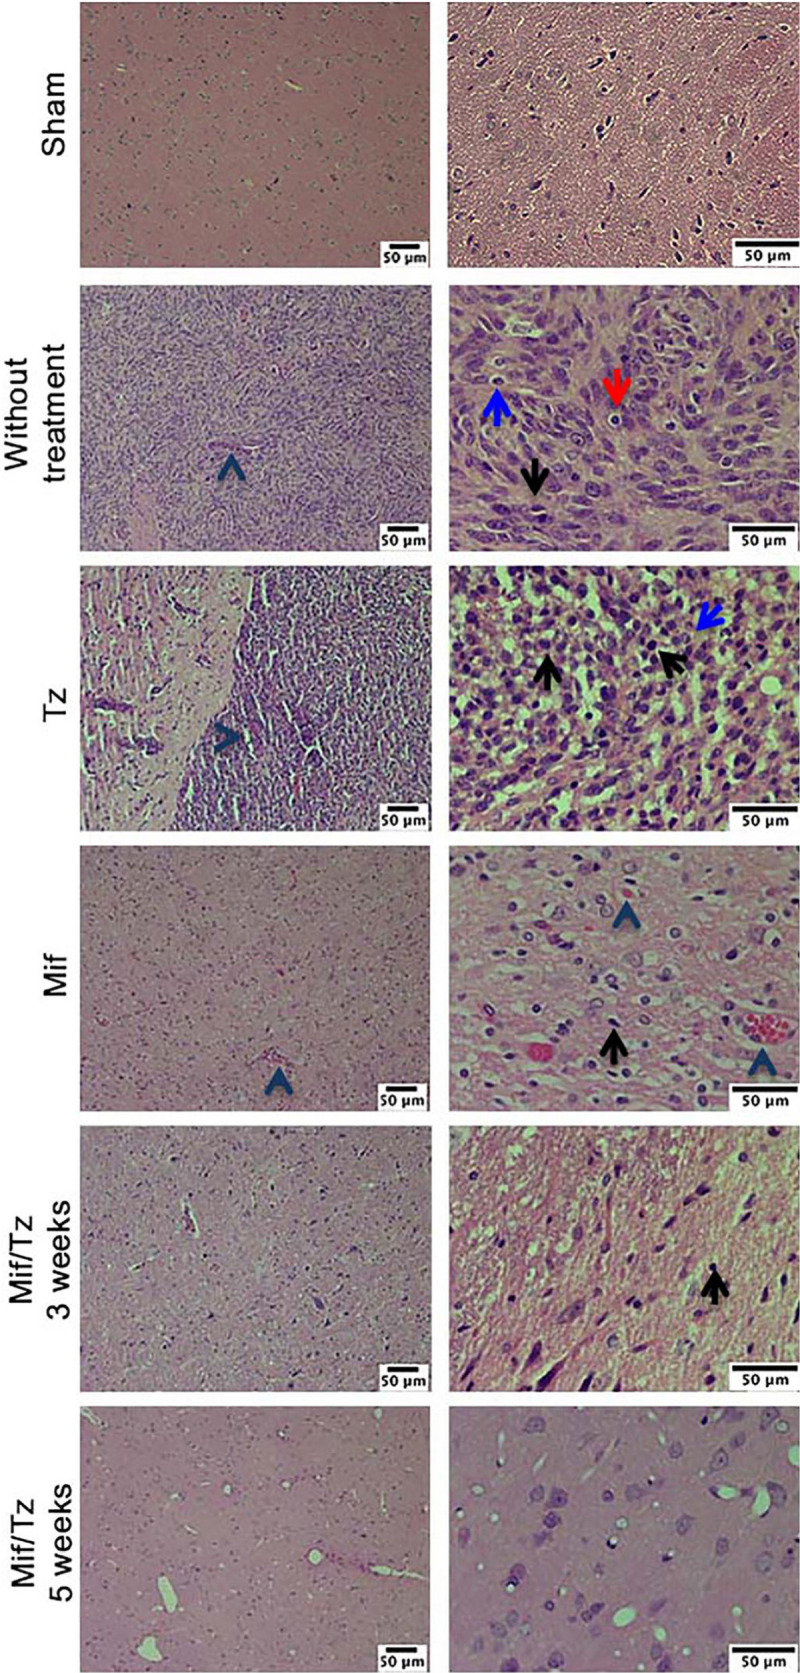
Hematoxylin and eosin (H&E) staining analysis of glioma tissue. Hyperbasophilic cells (black arrow), hyperchromatics cells (red arrow), vessel proliferation (arrowhead), mitosis (blue arrow). The images are representative of three animals per treatment Scale bars = 50 μm.